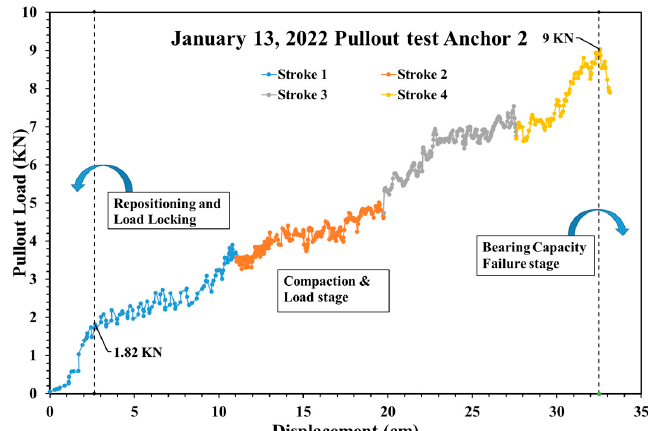
Figure 14. Anchor 2 pull-out test 1, southwest bank, 13 January 2022.